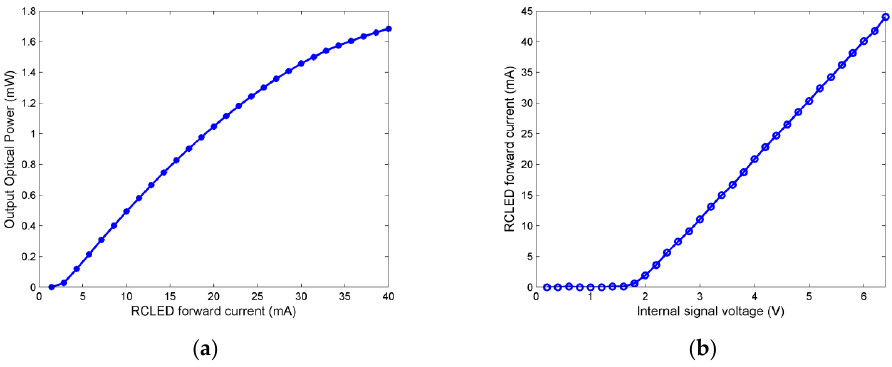
Figure 2. The measured results ( a ) the measured transformation of the RCLED; ( b ) the measured internal signal voltage and RCLED forward current.